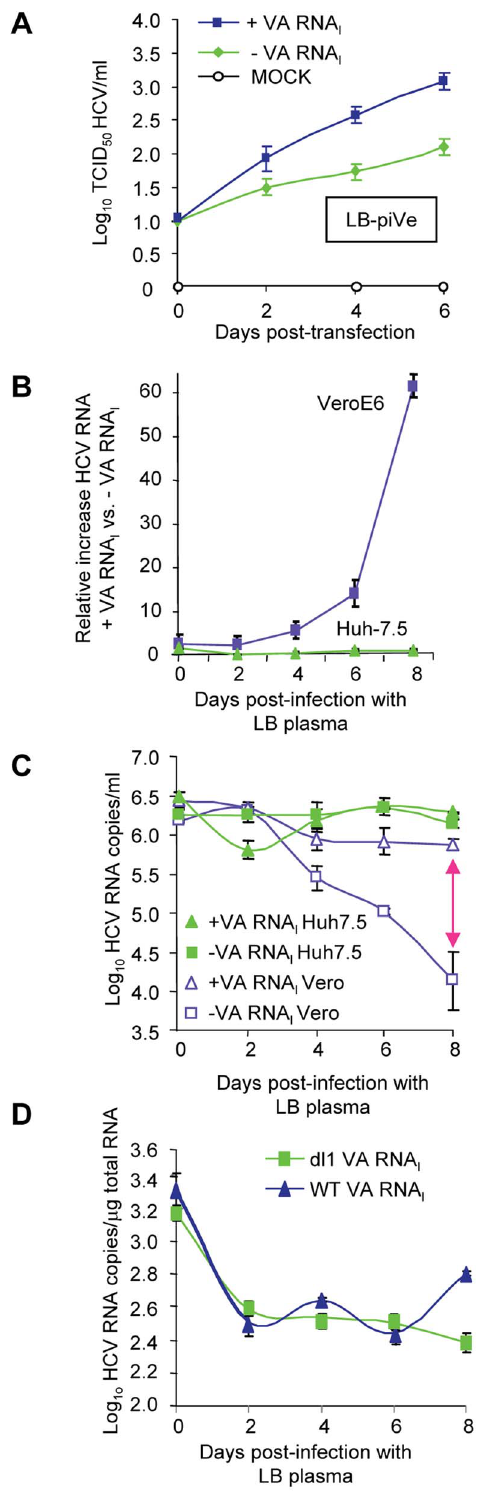
Figure 6. VA RNA I stimulates replication of HCV and increases RNA stability. (A) LB-piVe cells transfected with pVA ( + VA RNA I ) or dl1 ( 2 VA RNA I ). Filter-clarified culture supernatants were collected on days 0, 2, 4 and 6 (post-transfection) for virus titer determination by CPE- based TCID 50 assay. (B) VeroE6 or Huh7.5 cells transfected with pVA or dl1 and inoculated with genotype 1b-infectious human plasma (LB; [28,29]). HCV RNA was extracted from cell lysates at the indicated time points and the copy number was determined by quantitative